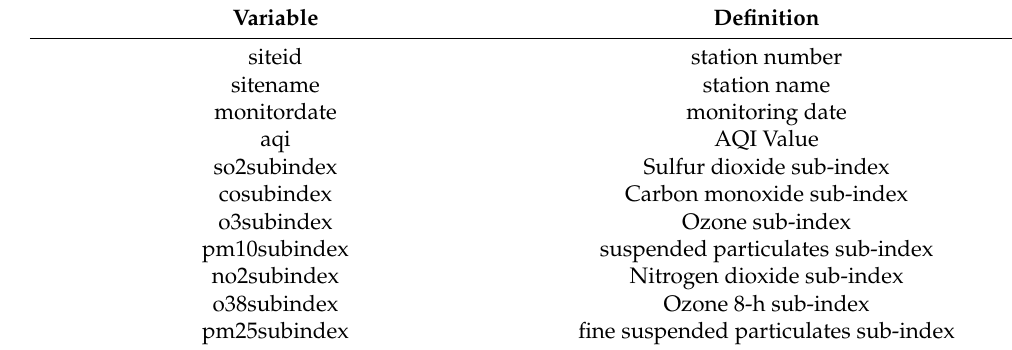
Table 1. Dataset variable description.